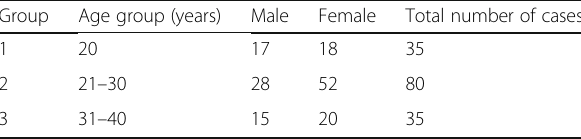
Table 1 Distribution of data based on age and sex of the individuals